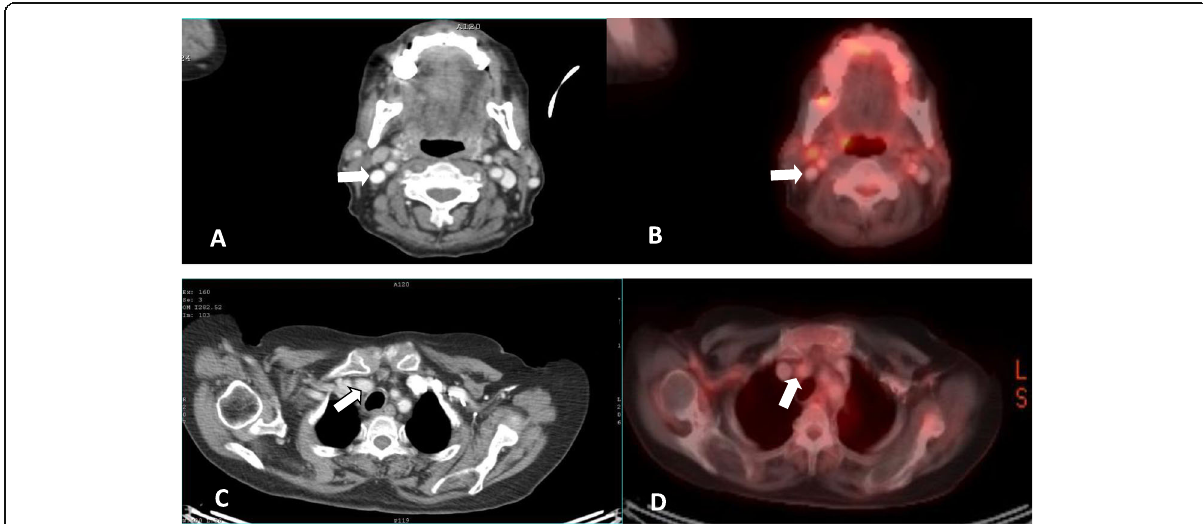
Fig. 7 Twenty-three-year-old patient, known case of Hodgkin lymphoma. Bilateral subcentimetric non FDG avid cervical LNs ( a and b ). Non FDG avid mediastinal LNs and thymic hyperplasia ( c and d ) with low grade metabolic activity with SUV max 4.14, consistent with a score 2 on the five point scale